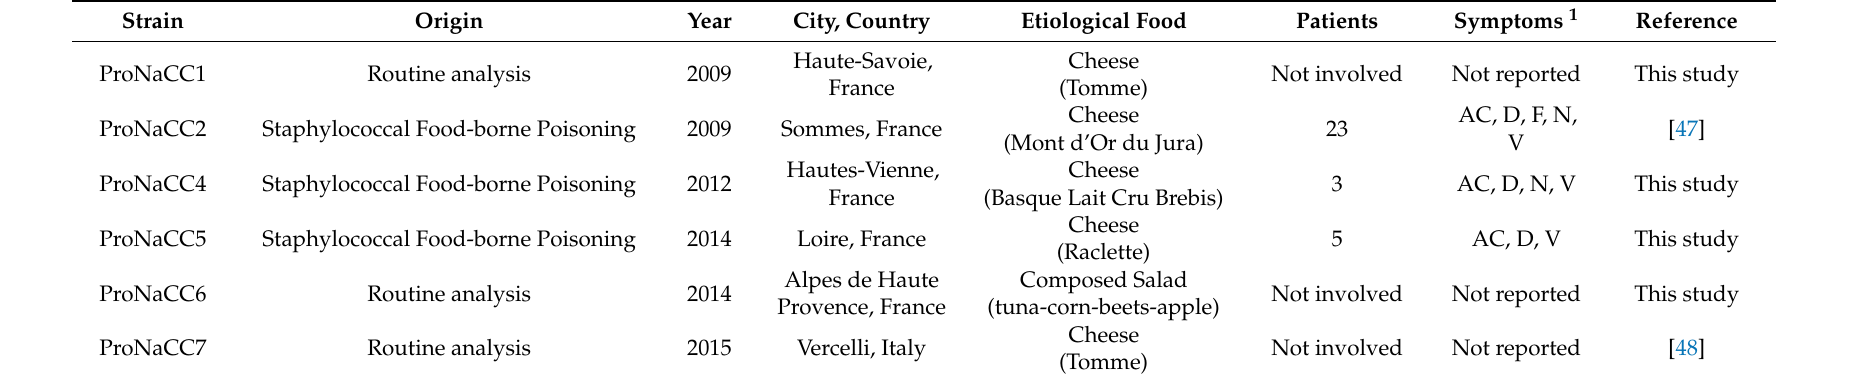
Table 1. Origin and details of the strains selected for this